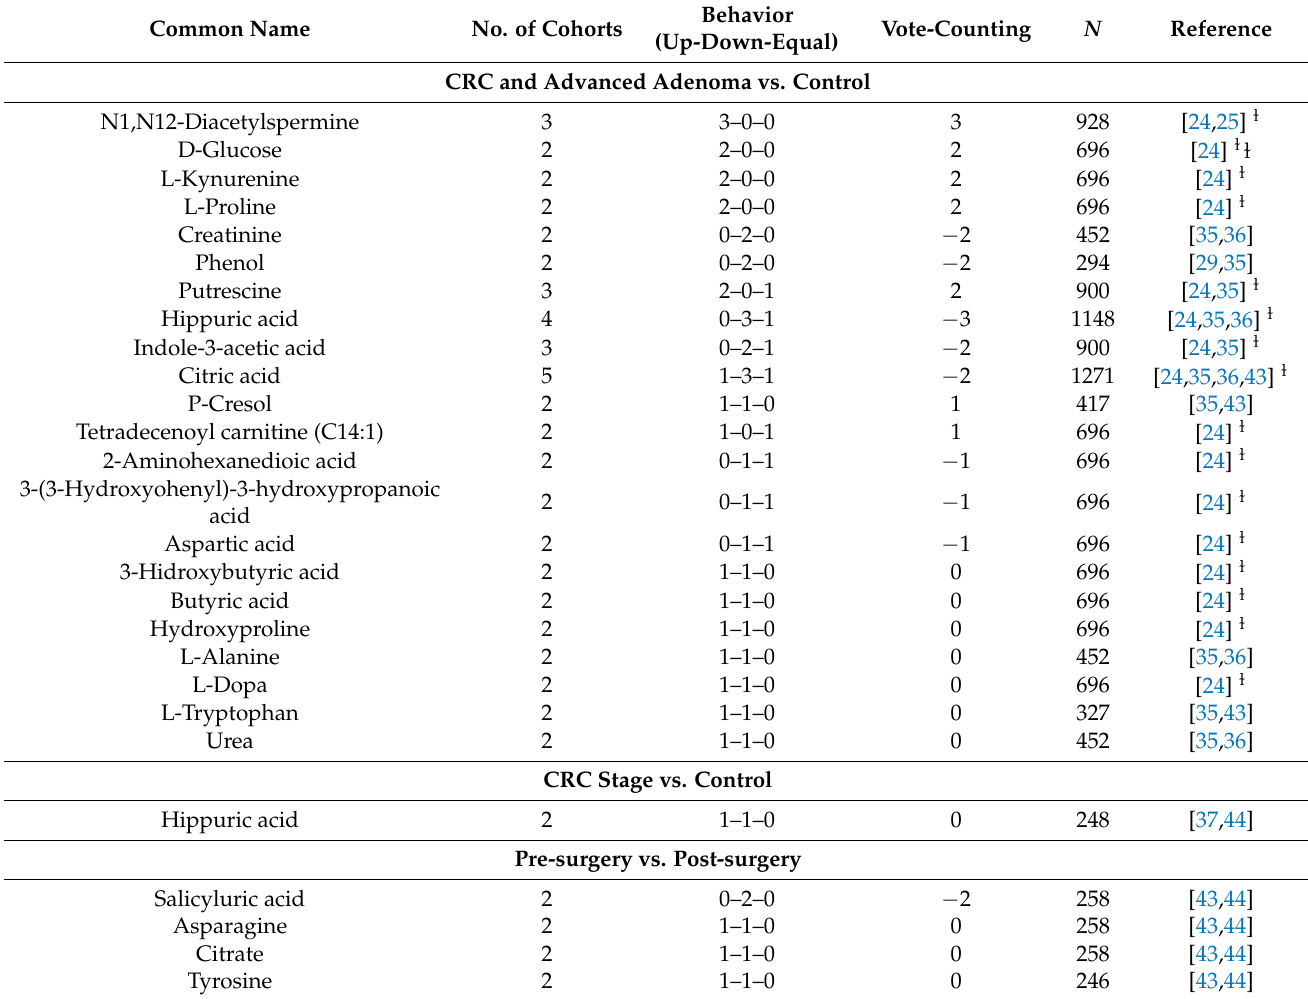
Table 3. Relevant compounds from the meta-analysis results considering only the vote-counting results. The compounds shown are found in at least two different cohorts. Compounds in bold have a vote count of at least 2 for the upregulated compounds and − 2 for the downregulated